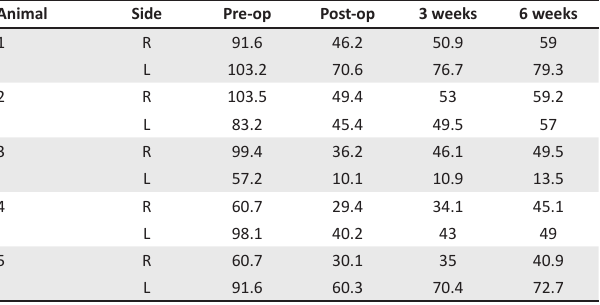
TABLE 1: Average grey scale values for the combined left and right maxillae and mandibles for each animal. Animal